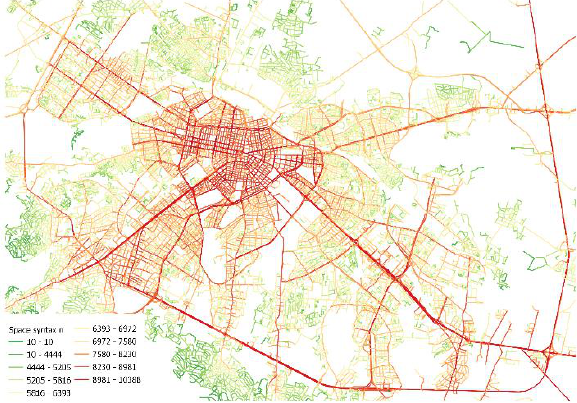
Figure 14. Spatial Syntax Integration Analysis without Search